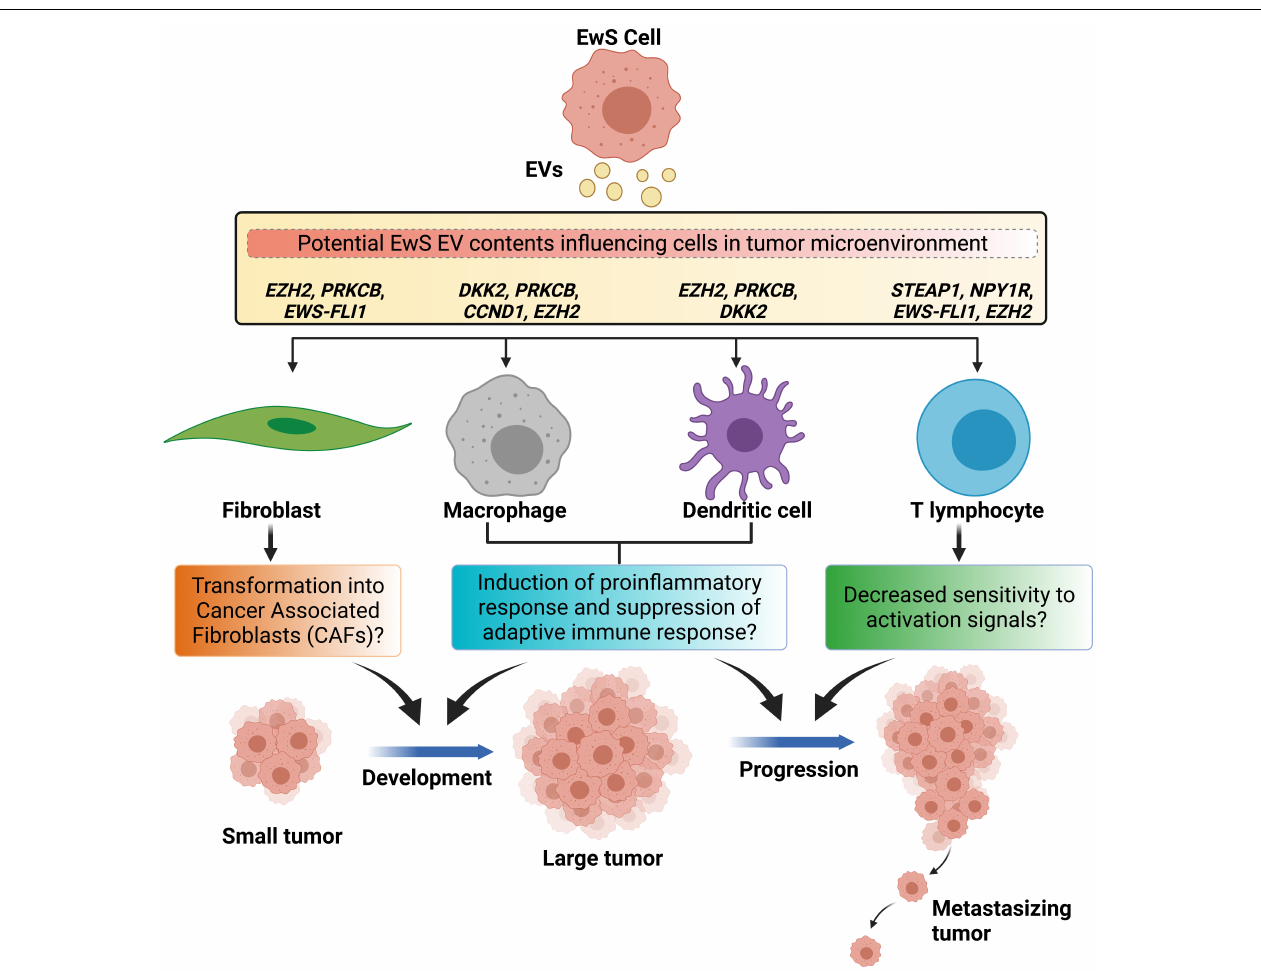
FIGURE 2 | Schematic representation of Ewing sarcoma extracellular vesicle-mediated reprogramming of cells in the tumor microenvironment. Ewing sarcoma (EwS)-derived extracellular vesicles (EVs) may cause transformation of normal fibroblasts into cancer-associated fibroblasts that majorly support the cancer development. EwS-derived EVs may cause tumor-associated macrophages and dendritic cells to produce excessive pro-inflammatory cytokines and cause suppression of tumor specific immune response, and support both the cancer development and its progression. EwS EVs may inhibit T cell-mediated response by decreasing activation associated signals, thereby causing cancer